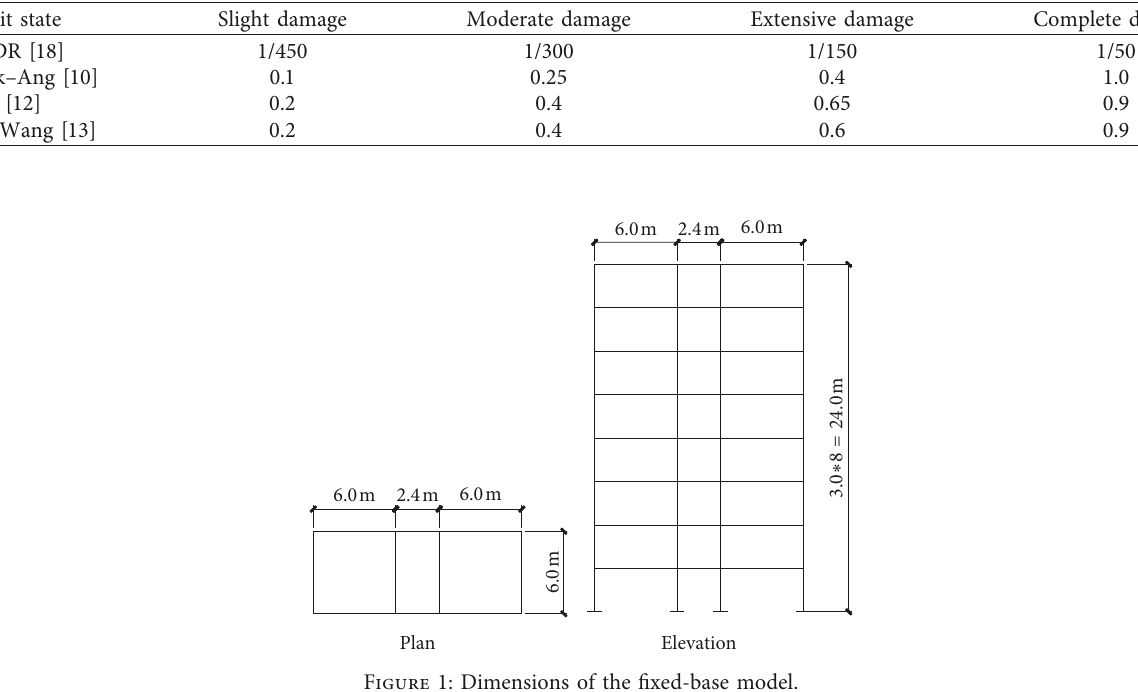
Table 3: Damage indices of the limit state.